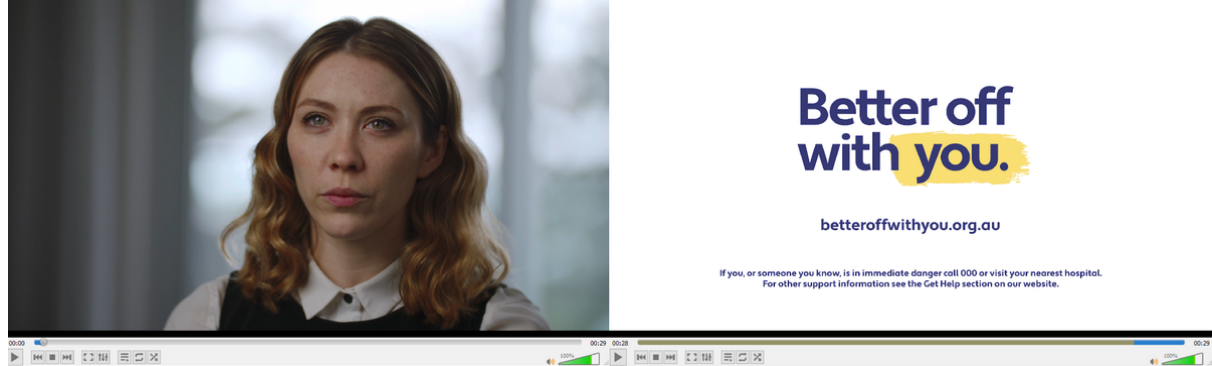
Figure 1. Screenshots of draft Better Off With You videos (video 1/6; Phoebe’s story; 30-second version) discussed in user testing